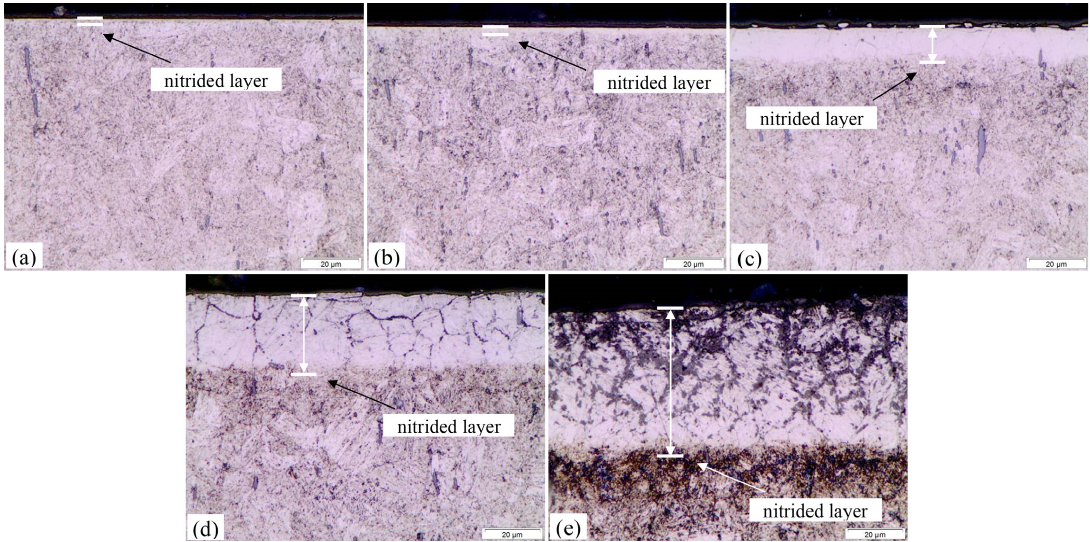
Figure 2. Cross-section micrographs of AISI 416 samples nitrided at: (a) 300, (b) 350, (c) 400, (d) 450, and (e) 500°C. Treatments carried out for 4 h, using a gas mixture composition of 70% N